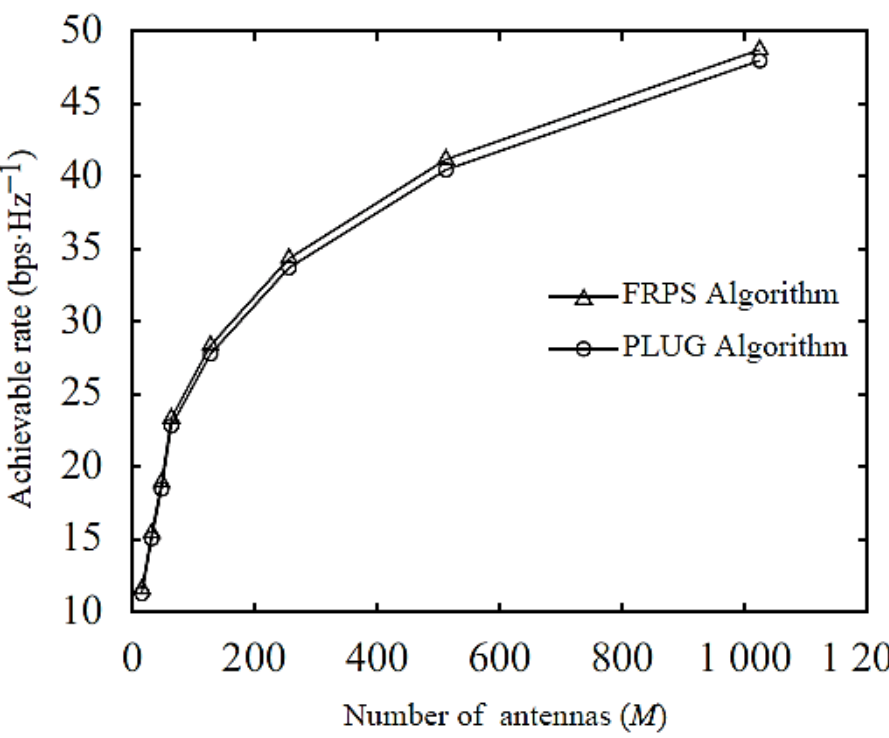
Figure 11. Achievable rate comparison of FRPS and PLUG algorithms for user fairness analysis.